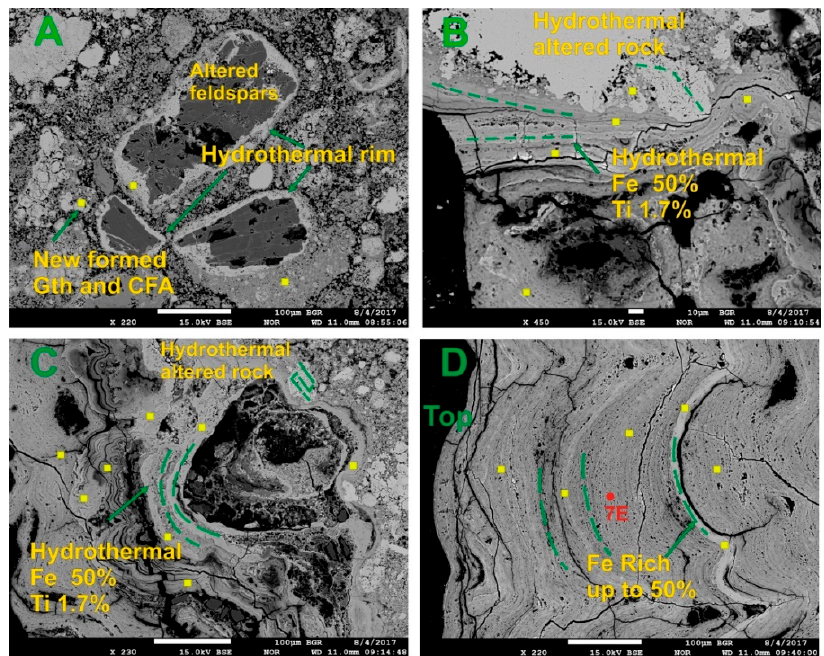
Figure 11. ( A – D ) EPMA images of crust 107-11H. ( A ) altered feldspars with hydrothermal rim and new formation of goethite and carbonate-fluorapatite (CFA) minerals in the substrate. ( B ) and ( C ) formation of hydrothermal Fe and Ti rich oxyhydroxides in the contact with the substrate rock; ( D ) hydrogenetic Fe-Mn layer intercalated with a continuous Fe rich lamina. EPMA spots’ analyses (yellow squares), FT-IR (red spot) and LA-ICP-MS (discontinuous green lines) have been marked.